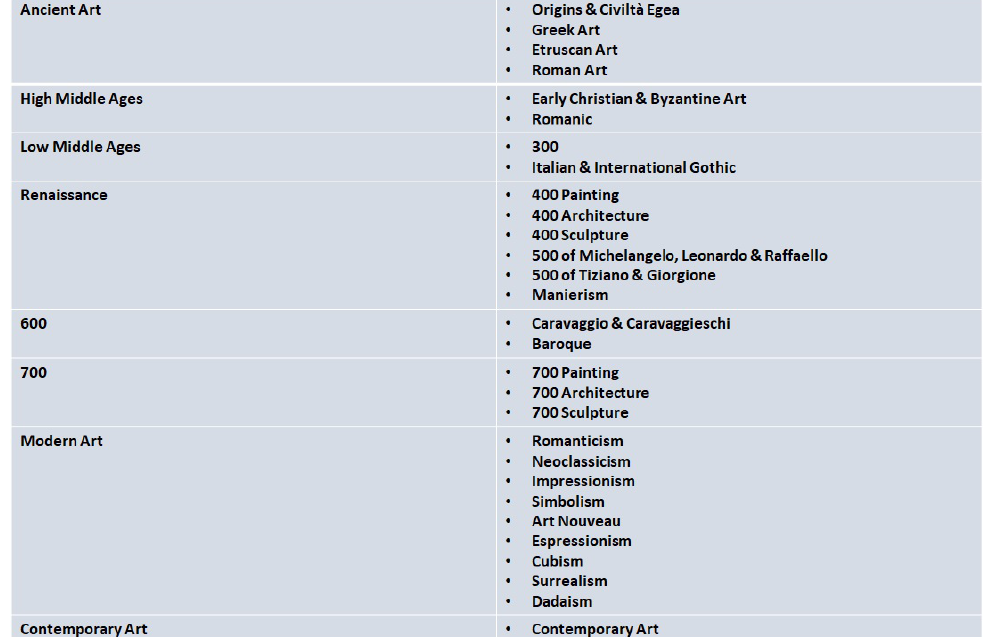
Figure 4. History of Art categorization based on Giulio Carlo Argan’s